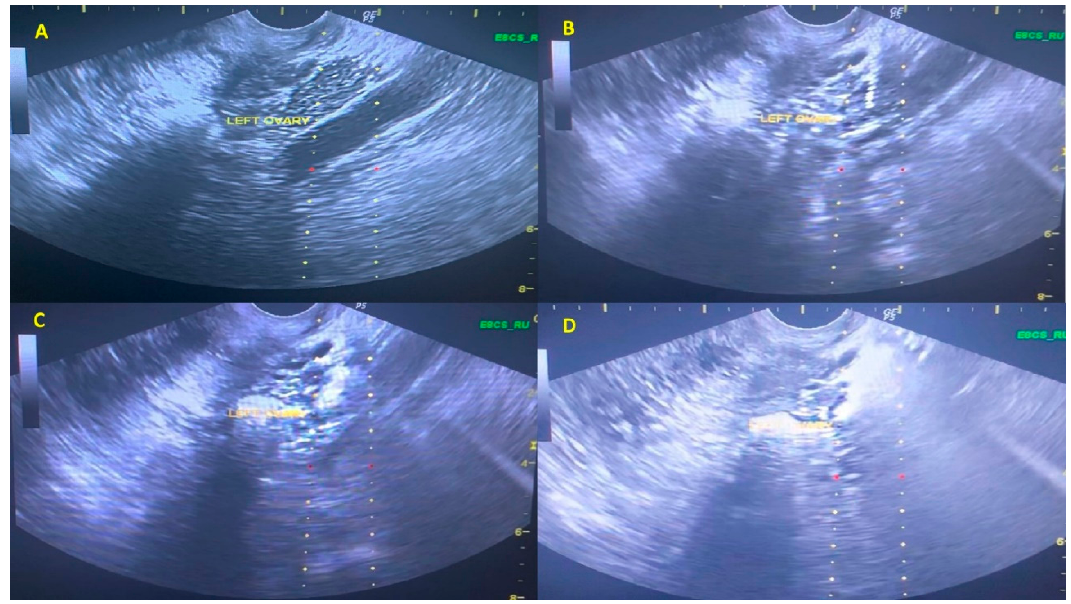
Figure 1. Sequence of images ( A – D ), illustrating the steps during PRP procedure on the left ovary. ( A ): Transvaginal Ultrasound Scan Image of the left ovary and the needle guide viewed prior to needle insertion. ( B ): Transvaginal Ultrasound Scan Image of the left ovary while the needle is fully inserted into cortex of the ovary. ( C ): Transvaginal Ultrasound Scan Image of the left ovary during PRP injection. ( D ): Transvaginal Ultrasound Scan Image of the left ovary aligned with the needle guide, following PRP injection.